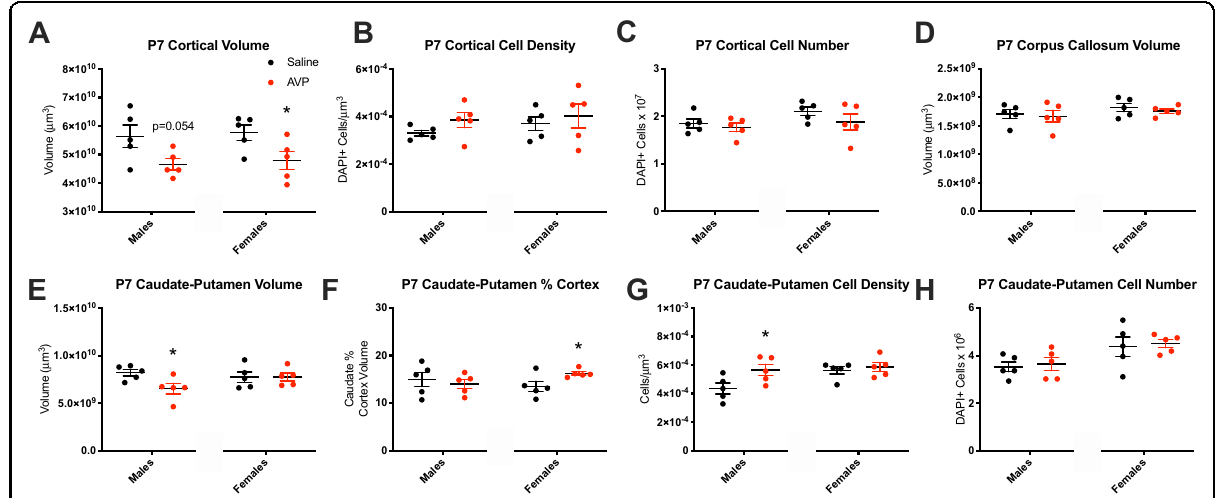
Fig. 3 Juvenile offspring neurobiology was altered by maternal AVP. a Cortical volume in postnatal day 7 (P7) offspring was trend-smaller in males ( p = 0.054) and signi fi cantly smaller in AVP-exposed females ( p = 0.047). b Cortical cell density and ( c ) cell number were not changed by AVP at P7, ( d ) nor was corpus callosum volume, in either sex. e The caudate – putamen was smaller by volume in P7 male AVP-exposed offspring ( p = 0.032), while ( f ) caudate – putamen volume relative to cortical volume was increased among P7 AVP-exposed females ( p = 0.043). g The density of cells in the caudate was increased in P7 AVP-exposed males ( p = 0.046), resulting in ( h ) an unchanged number of cells with AVP exposure in either sex. * p < 0.05 per two-sample t -test, error bars represent SEM. 2 litters per condition, 2 – 3 brains per sex per